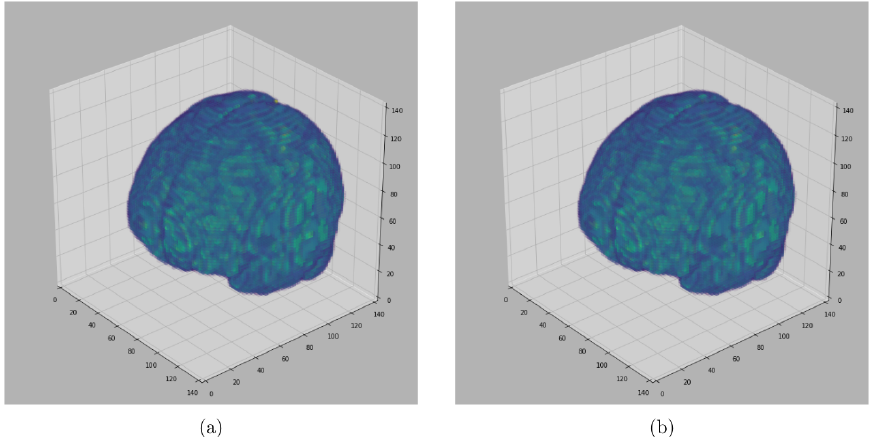
Figure 7. Segmented Brain (BW data): One representative subject representing ( a ) 3D brain segmented using GUBS approach (predicted), ( b ) 3D brain (ground truth). The ground truth was obtained from the labels representing cerebrospinal fluid (CSF), gray matter (GM), and white matter (WM).